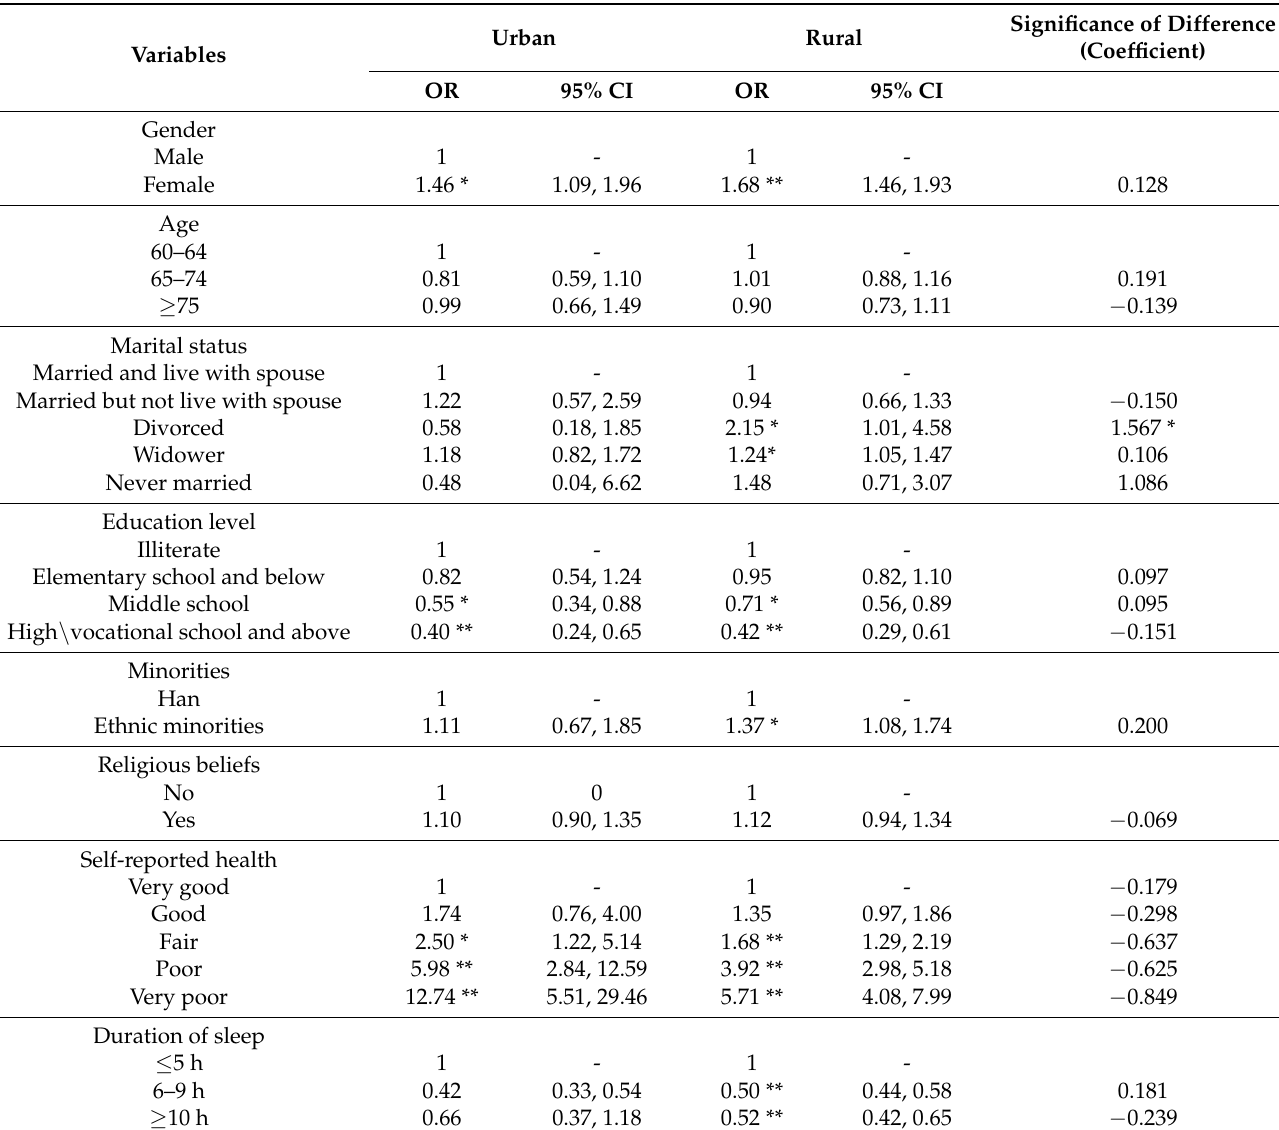
Table 5. Determinants and their effects on depression of the elderly in urban and rural areas by logistics